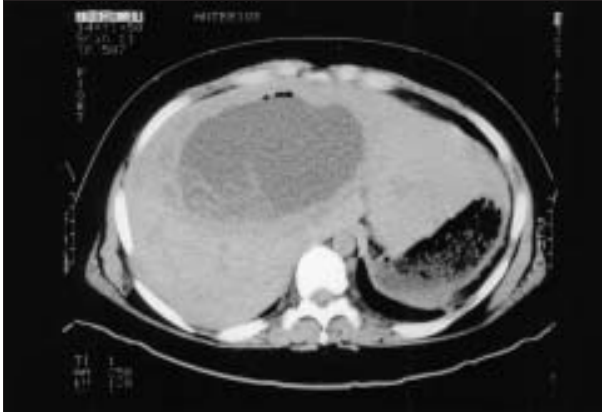
Figure 1) Computed tomography scan showing a large, well circum- scribed, low density, 26 cm mass arising from the medial segment of the left lobe of the liver. There was considerable dense debris within the dependentportionofthismass. Themassproducedmilddilationofthe left intrahepatic biliary